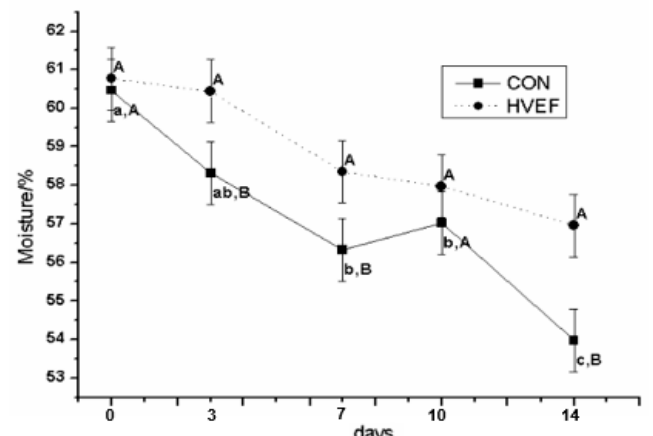
Figure 2. Influence of HVEF on moisture content of dry-cured beef during storage. Different capital letters indicate significant differences ( p < 0.05) between treatments in the same time and small letters indicate significant differences ( p < 0.05) between times in the same treatment. Error bars reflect standard errors.